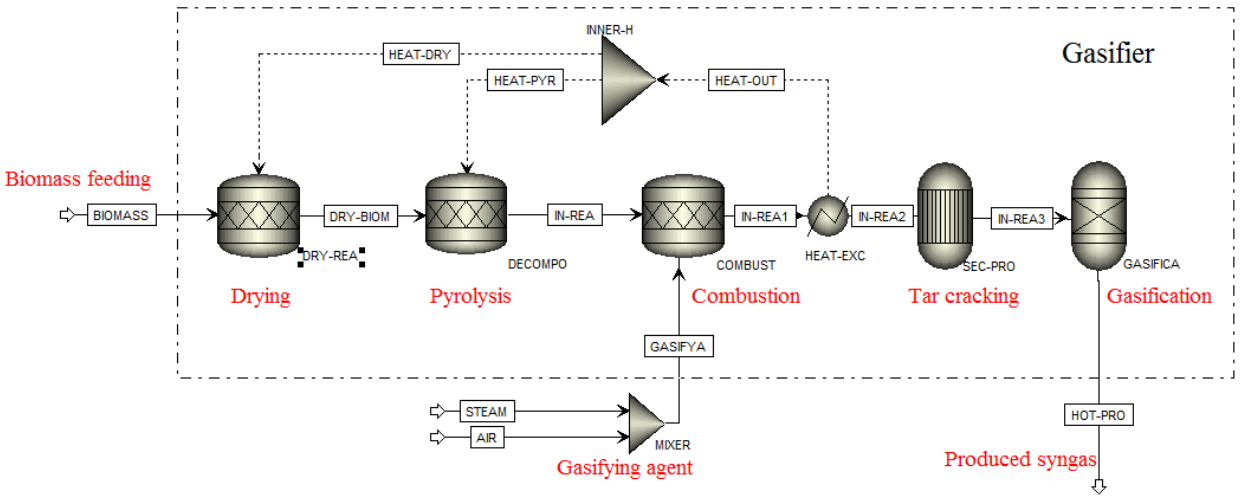
Figure 2. ASPEN PLUS flow sheet for the HTAG